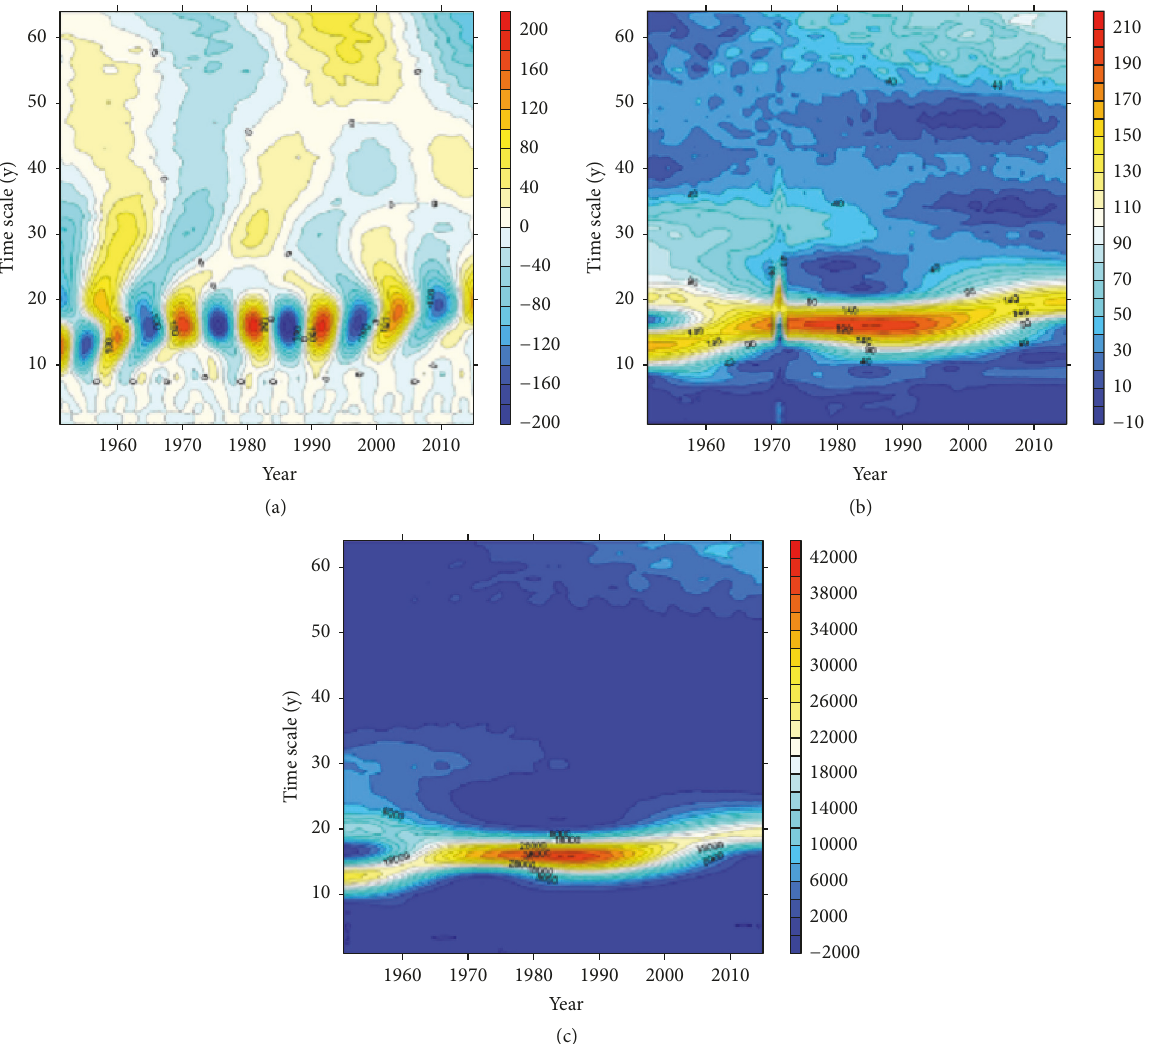
Figure 5: The real part, modulus, and the second modulus power of the wavelet coefficient contour of precipitation: (a) real part wavelet coefficient contour map of sunspot number; (b) modulus of wavelet coefficient contour map of sunspot number; (c) the second modulus power of the wavelet coefficient contour map of sunspot number.